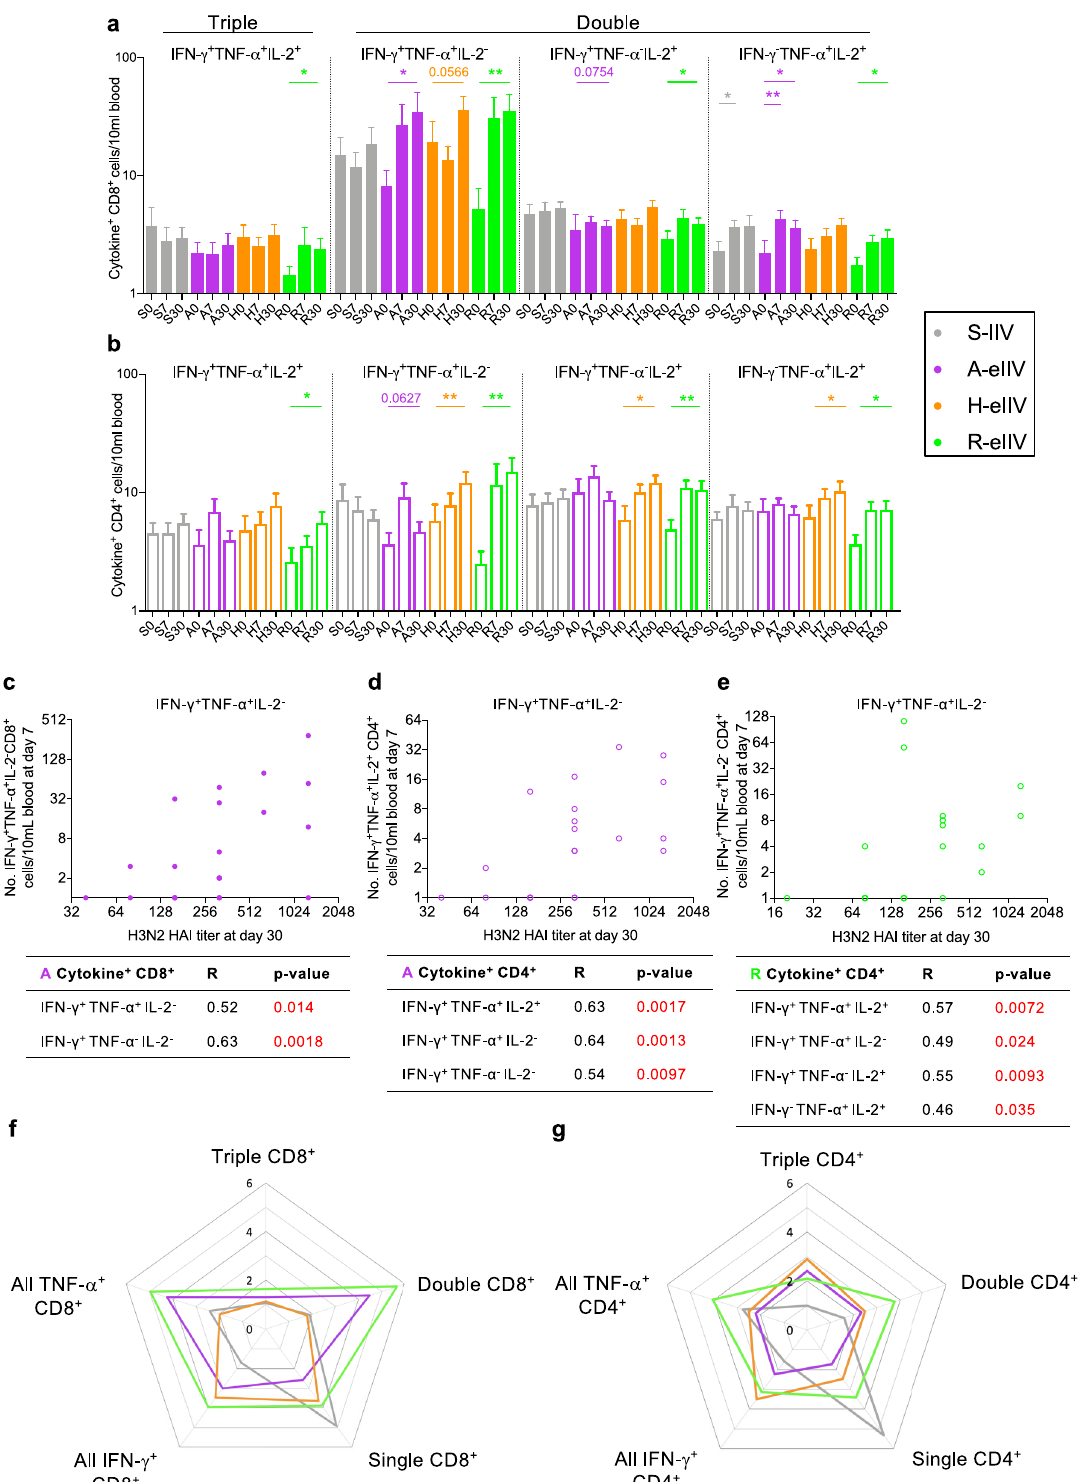
Fig. 4 A(H3N2)-speci fi c polyfunctional T cell responses are expanded by enhanced vaccination. The magnitude of multiple-cytokine- secreting a CD8 + and b CD4 + T cells at days 0, 7, and 30 post vaccination. Data represented as mean (S, n = 24; A, n = 24; H, n = 23; R, n = 23) with SEM, the signi fi cance by Friedman ’ s test. Spearman ’ s correlation between A(H3N2) HAI titers at day 30 and the recruitment of c day 7 cytokine + CD8 + subsets in A-eIIV recipients, and d cytokine + CD4 + subsets in A-eIIV recipients and in e R-eIIV recipients. Radar charts depicting mean fold induction of f CD8 + and g CD4 + T cell responses at day 7. * p < 0.05, ** p <